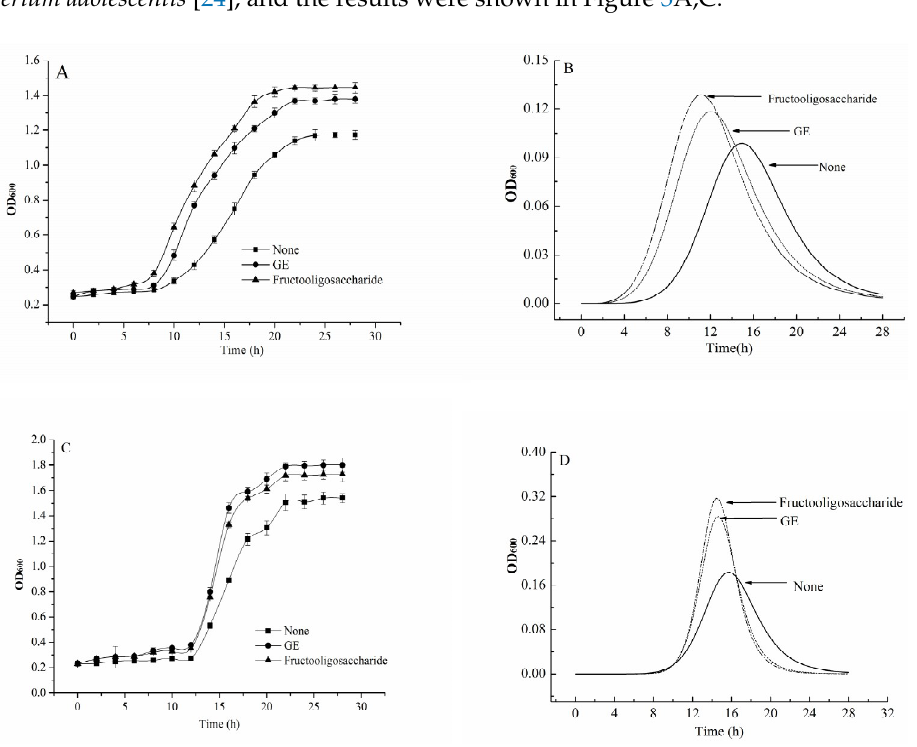
Figure 3. Evolution profiles of strains biomass ( A , C ) and specific growth rate ( B , D ) of Lactobacillus bulgaricus and Bifidobacterium adolescentis involving in the addition of GE (20 mg/mL) and fructooligosaccharide (20 mg/mL) with culture time.